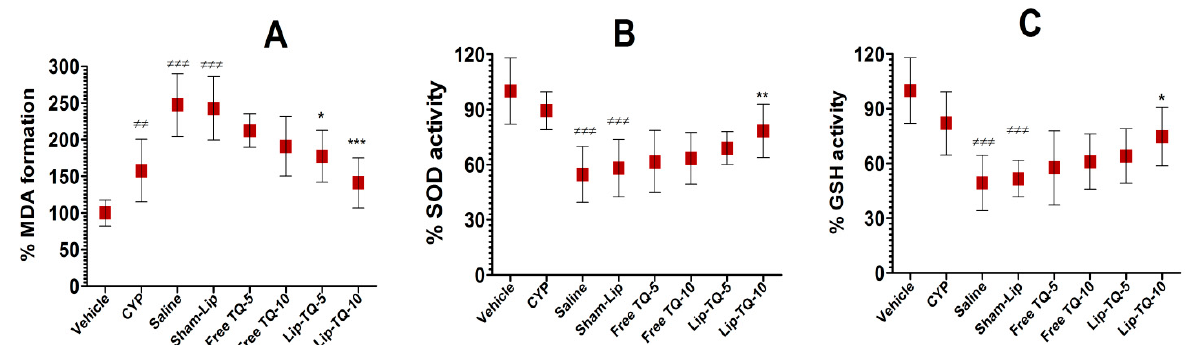
Figure 6. Lip-TQ therapy decreased the status of oxidative stress in the lung tissues. ( A ) MDA. ≠≠ ( p < 0.01) Saline vs. CYP, ≠≠≠ ( p < 0.001) CYP vs. Saline or Sham-Lip, * ( p < 0.05) Sham-Lip vs. Lip-TQ-5, *** ( p < 0.001) Sham-Lip vs. Lip-TQ-10. ( B ) SOD. ≠≠≠ ( p < 0.001) CYP vs. Saline or Sham-Lip, ** ( p < 0.01) Sham-Lip vs. Lip-TQ-10. ( C ) GSH. ≠≠≠ ( p < 0.001) CYP vs. Saline or Sham-Lip, * ( p < 0.05) Sham-Lip vs. Lip-TQ-10. The data are represented as the mean ± SD of three independent values. The data were analyzed by one-way ANOVA followed by the Turkey post-test.